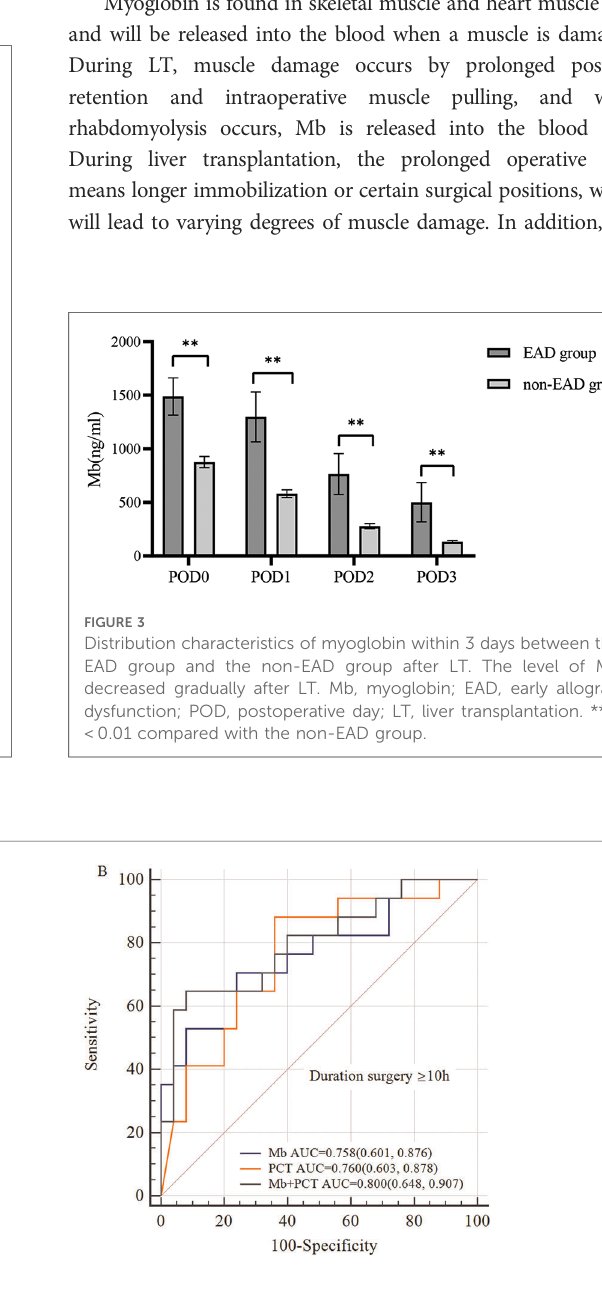
FIGURE 4 Subgroup analysis for ROC curves. ( A ) ROC curves of Mb, PCT, and Mb+PCT for EAD in patients whose preoperative MELD ≤ 15; ( B ) ROC curves of Mb, PCT, and Mb+PCT for EAD in patients whose operative time ≥ 10 h. The predictive value was better in patients whose preoperative MELD ≤ 15 or operative time ≥ 10 h (AUC=0.751, 0.758, respectively, for Mb).